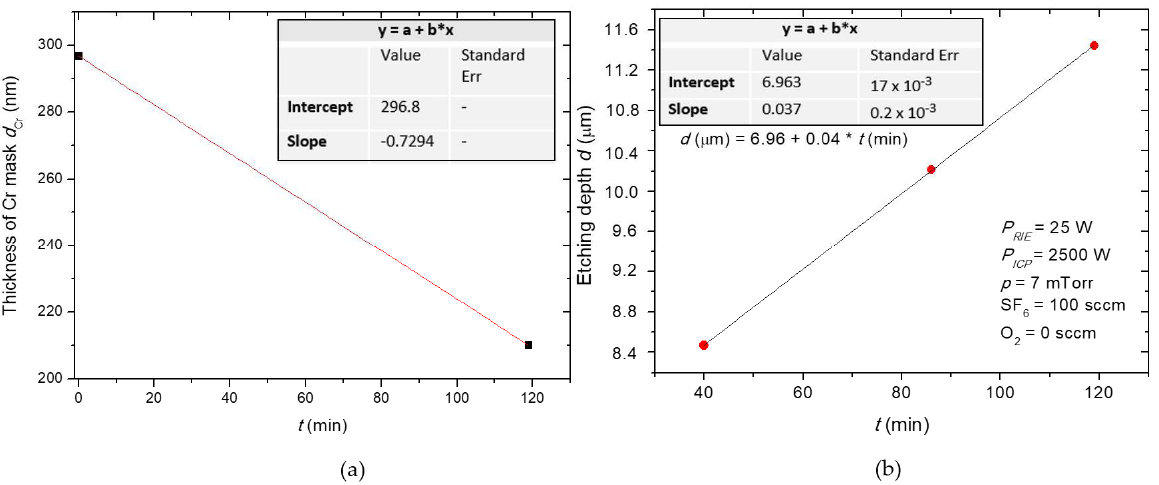
Figure 18. ( a ) The SEM photo of the SiC/Cr MESA structure with ( b ) ~210 nm layer of chromium at the top (the result of 119 min etching).